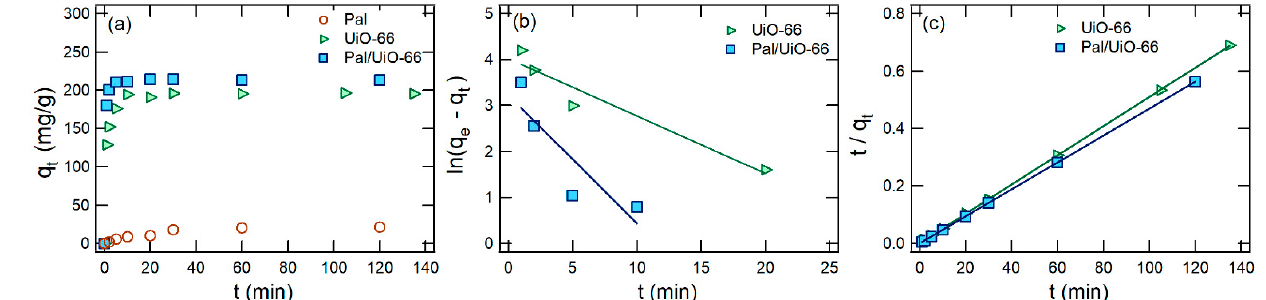
Figure 5. Time dependence of MO adsorption on the pure UiO-66 and Pal samples as well as the Pal/UiO-66 composite material ( a ). Plots of pseudo-first- ( b ) and pseudo-second-order rate-law ( c ) for MO adsorption on pure the UiO-66 and Pal/UiO-66 composite. Experimental conditions: 90 mg L − 1 initial MO concentration, 0.4 g L − 1 of the adsorbent, pH = 5, volume 50 mL, and T = 25 °C.